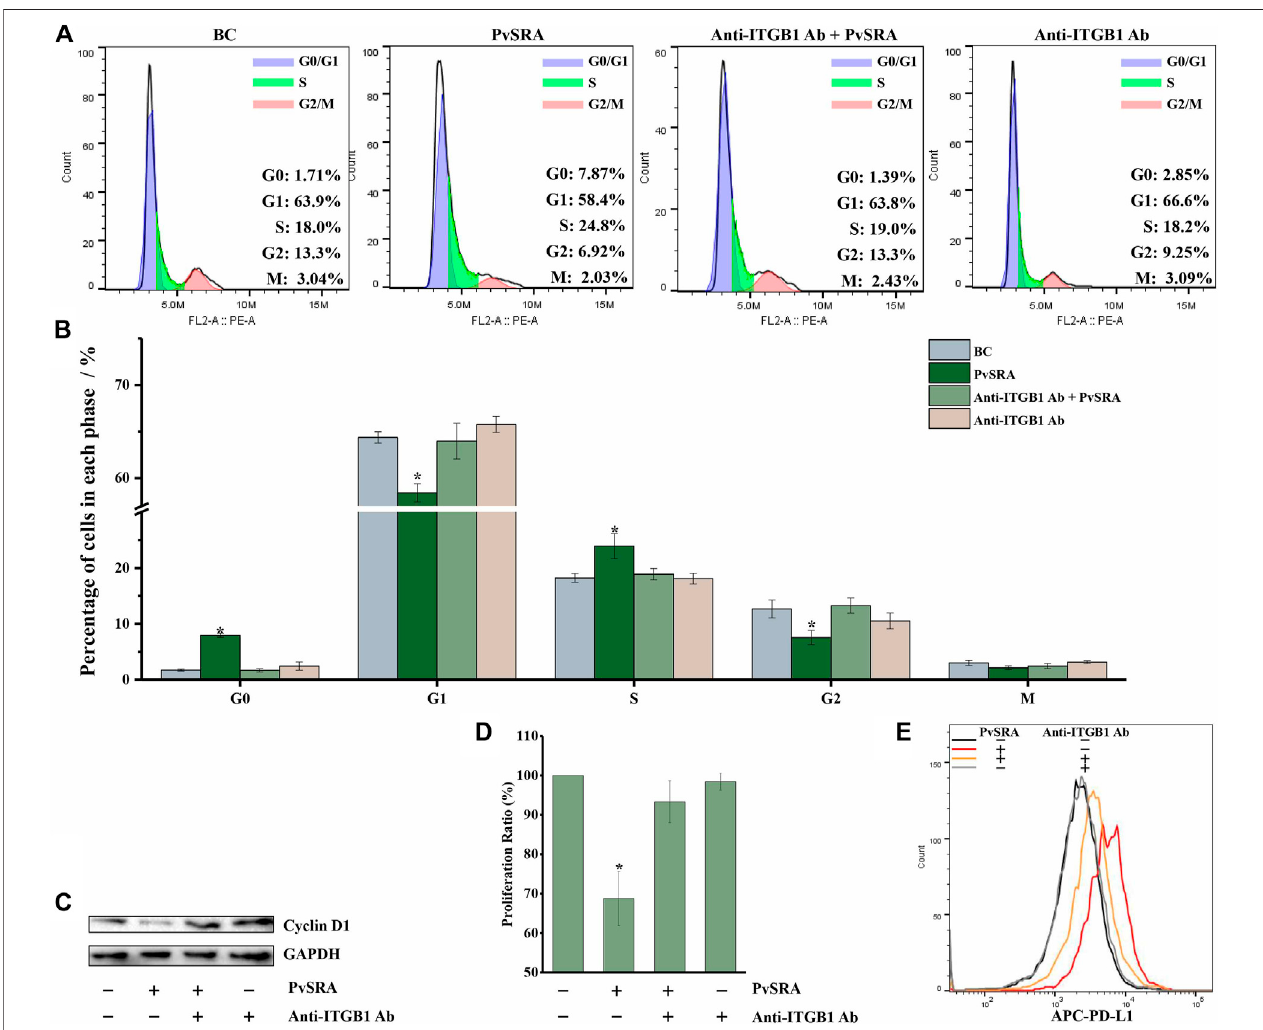
FIGURE 7 | PvSRA has a negative effect on HSF cell cycle and increased PD-L1 expression on HSF surface through PvSRA – ITGB1 axis. (A) The effect of PvSRA on HSF cell cycle was tested by FACS. (B) Histogram of the changes of cell ration in different cell cycle phase. Asterisk (*) represents that it has statistic difference with other groups in same phase. (C) WB analysis was used to test the expression of cell cycle – related protein Cyclin D1. (D) CCK8 test was applied to assay the effect of PvSRA on HSF proliferation. Asterisk (*) represents that it has statistic difference with other groups in same phase. (E) FACS was applied to test the PD-L1 expression on HSF cell